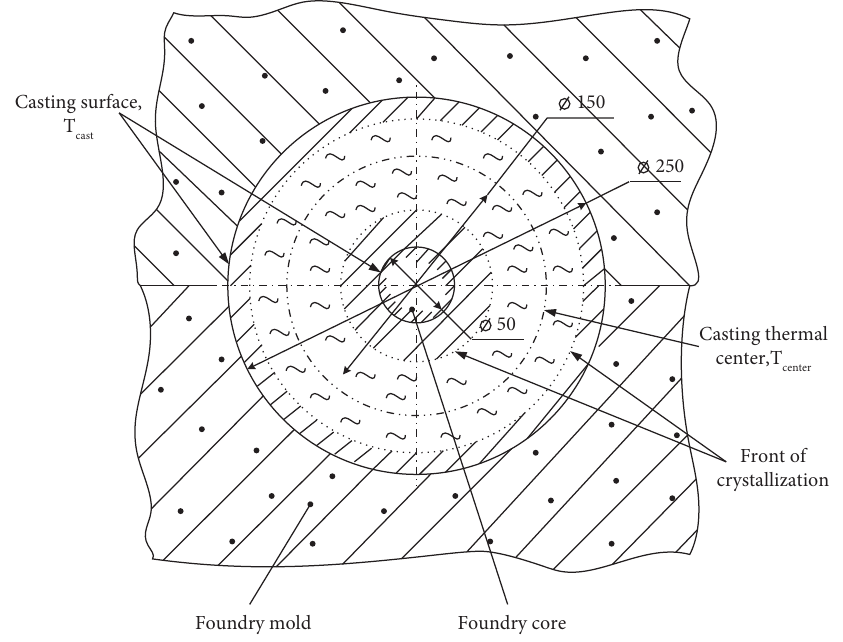
Figure 1: Calculation scheme of the steel casting with the foundry